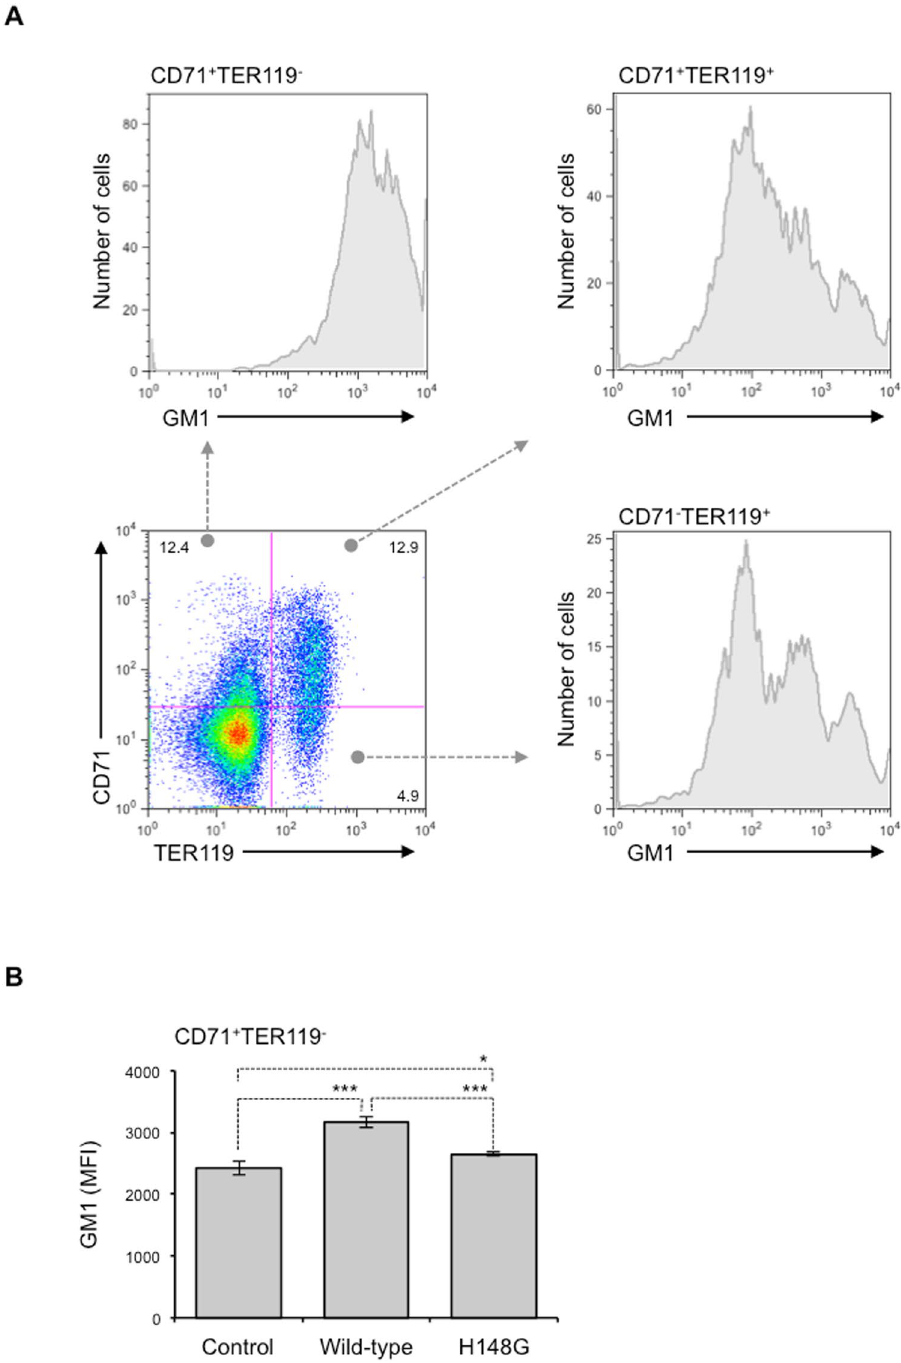
Figure 6. α - Toxin increases expression of GM1 in erythroblasts. ( A ) BMCs were labeled with Alexa Fluor 647- CTB and specific antibodies against CD71 and TER119. The cells were analyzed using a Guava easyCyte, and fluorescence of Alexa Fluor 647-CTB in three different populations (CD71 + TER119 − , CD71 + TER119 + , and CD71 − TER119 + cells) was determined. ( B ) A total of 5 × 10 6 bone marrow cells were treated with 100 ng/ml α -toxin (Wild-type) or a variant α -toxin, H148G (H148G), for 24 hours, and the cells were labeled as described above. Fluorescence of Alexa Fluor 647-CTB in the CD71 + TER119 − cell population was determined, and the mean fluorescence intensity was compared with that of α -toxin-untreated cells (Control). One-way ANOVA was employed to assess statistical significance. Values are mean ± standard deviation. * P < 0.05; *** P <